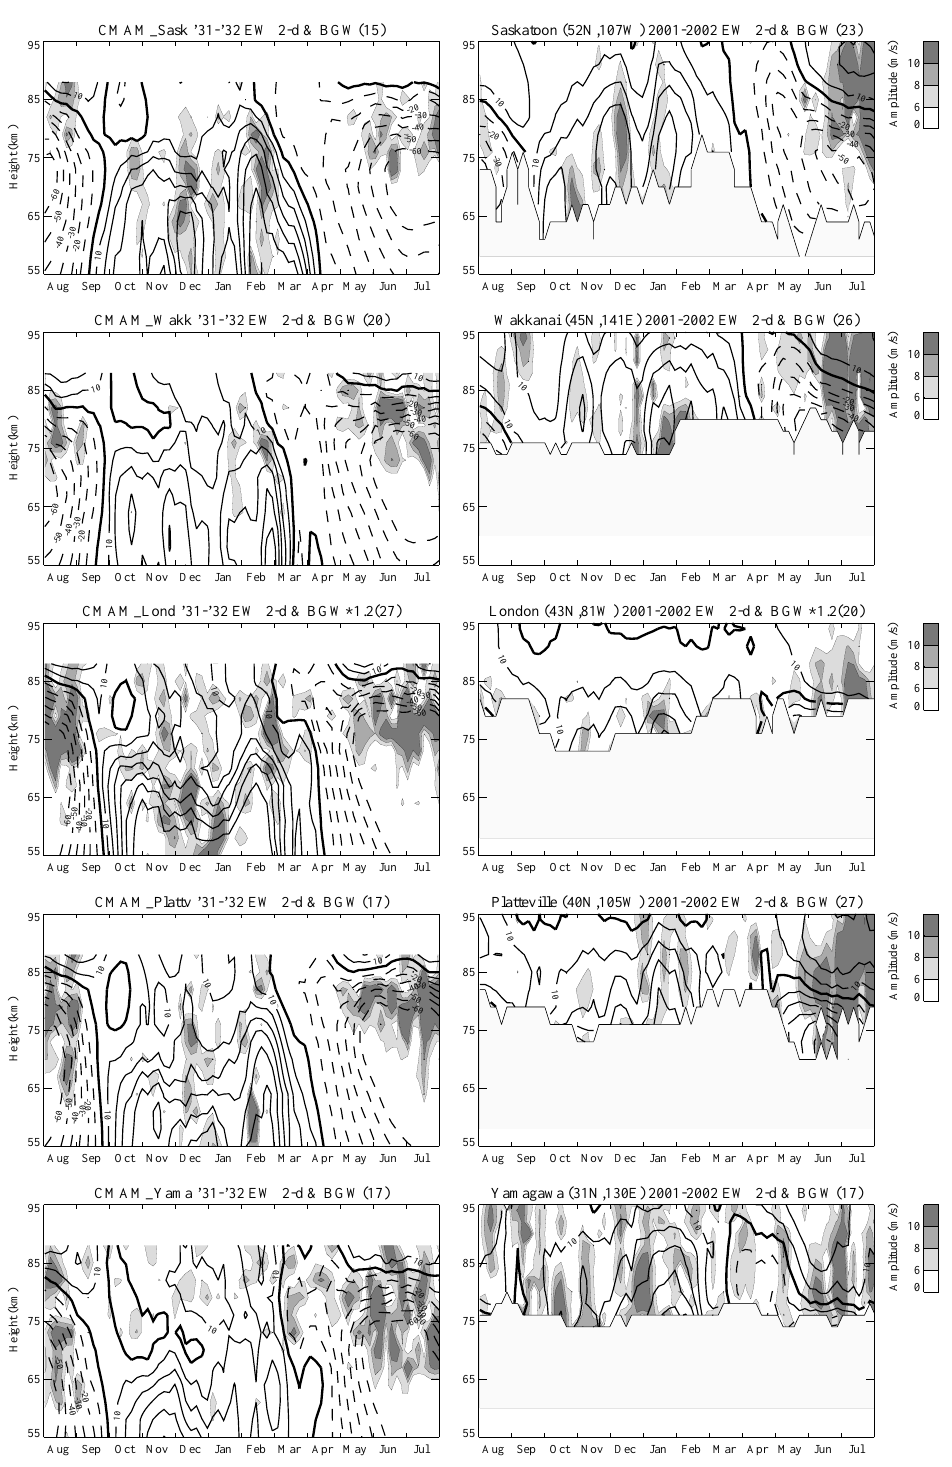
Fig. 12. Amplitudes of the 2-d planetary wave (NS and EW) resulting from a fourier analysis (bandwidth 1.5–3 days; 24-day window length shifted in 5-day steps over the year) of CMAM data (model-years 31/32) and of MF radar data (years 2001/02). For each window-length the mean (24-days) is removed and used to represent the background wind: continuous lines for eastwards winds, dashed lines for the westward. The locations are Saskatoon, Wakkanai, London and Platteville. Data amplitudes from London’s MFR are multiplied by a factor of 1.2 due to a bias in the local analysis. The number in brackets at the top of each panel gives the maximum value found in those data.